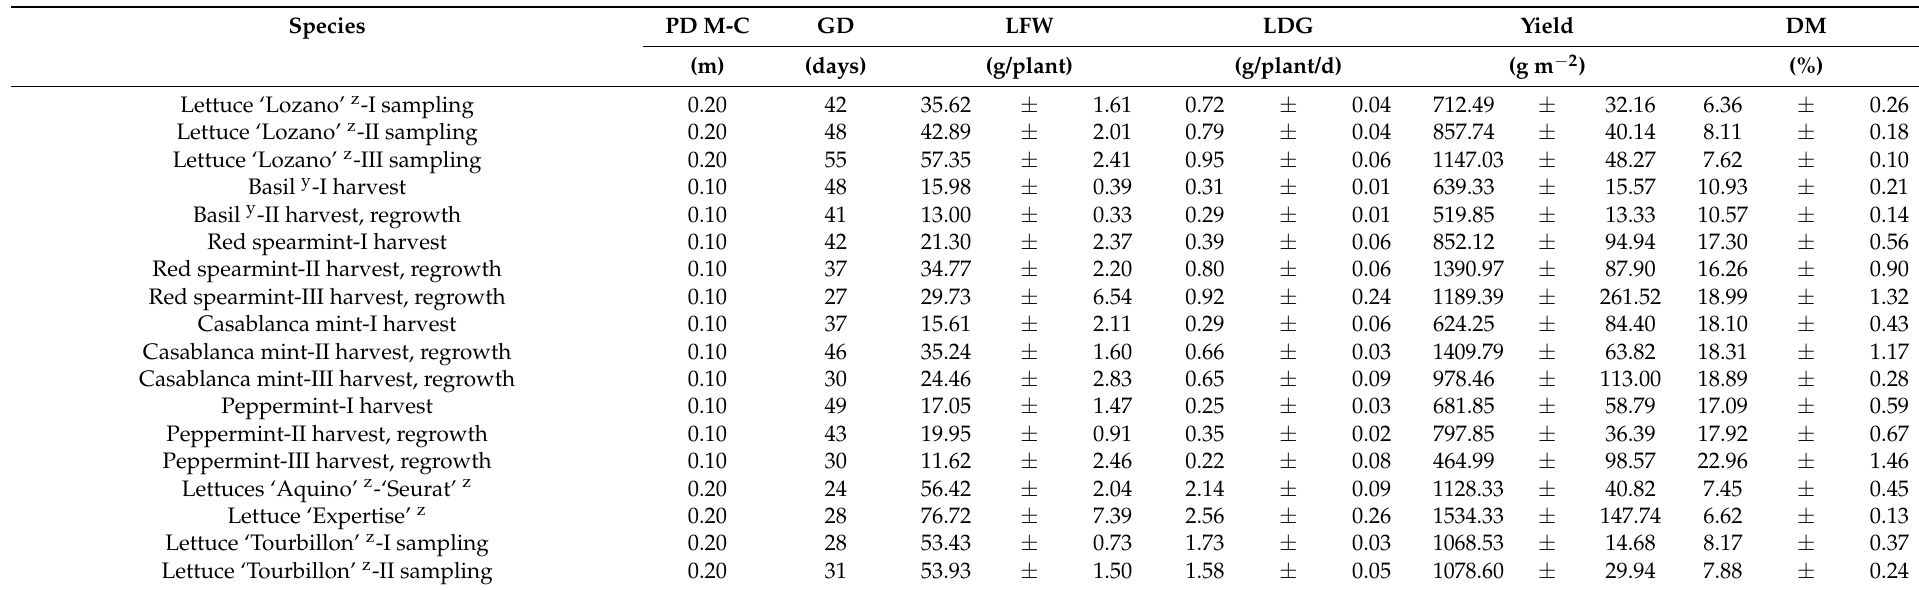
Table 1. Distance between plants in the multi-channel (PD M-C), growth duration (GD) leaf fresh weight (LFW) per plant, leaf daily growth (LDG), yield per square meter, dry matter (DM) in the leafy vegetables and culinary herbs grown in the New Growing System (NGS ® ) using the lab-scale pilot plant. The LFW, Yield and DM of the lettuce ‘Lozano’-I sampling; red spearmint-II harvest, regrowth; Casablanca mint-II harvest, regrowth are the means of ≈ 60 plants ± standard error (SE). The LFW, Yield and DM of the lettuce ‘Lozano’-II sampling and III sampling are the means of ≈ 30 plants ± SE. The LFW, Yield and DM of basil-I harvest are the means of ≈ 120 plants ± SE. The LFW, Yield and DM of basil-II harvest, regrowth are the means of ≈ 100 plants ± SE. The LFW, Yield and DM of red spearmint-I harvest and III harvest, regrowth; Casablanca mint-I harvest and III harvest, regrowth; peppermint-The LFW, Yield and DM of peppermint-III harvest, regrowth are the means of ≈ 50 plants ± SE. The LFW, Yield and DM of the lettuces: ‘Aquino’-‘Seurat’ and ‘Tourbillon’-I sampling and II sampling are the means of 25 plants ± SE. The LFW, Yield and DM of the lettuce ‘Expertise’ are the means of 10 plants ± SE. Seeds provided by: z Rijk Zwaan; y Sais